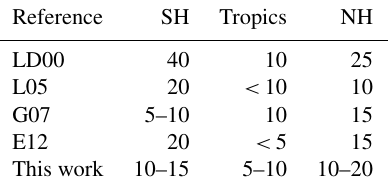
Table 4. Comparison of different studies with respect to the contri- bution (%) of stratospheric ozone to the tropospheric ozone concen- tration. Numbers are rough estimates only, as taken from published figures. Note that values for L05 are surface values only and per- centage values from E12 are estimated from mixing ratios; however, a mean value of 17% is given therein. See text for more explana- tions. SH and NH are abbreviations for the Southern and Northern Hemispheres,